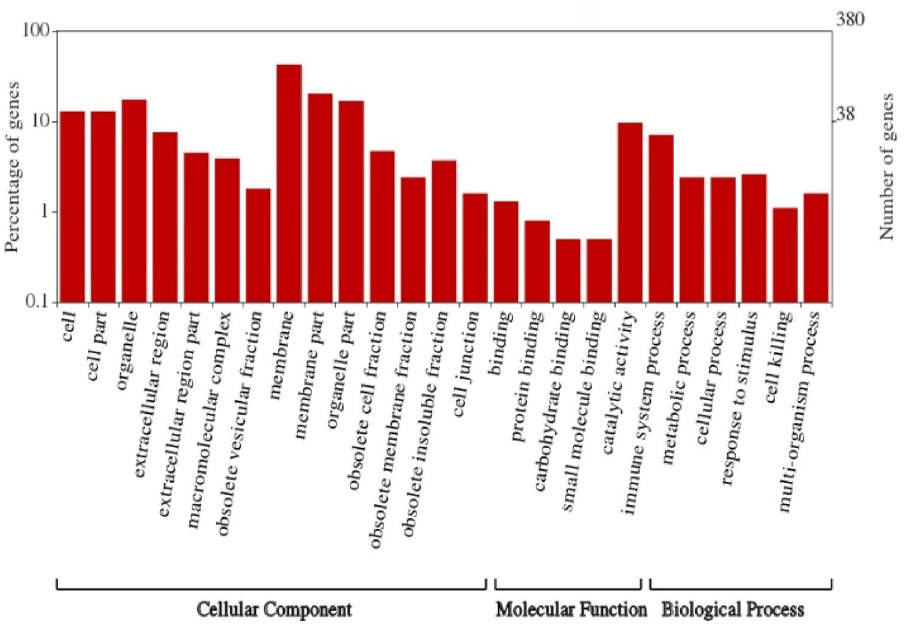
Figure 5. Percentages of DEGs identified in cellular components, molecular functions and biological processes. The left axis shows the percentage of genes in a category and the right axis shows the number of genes.